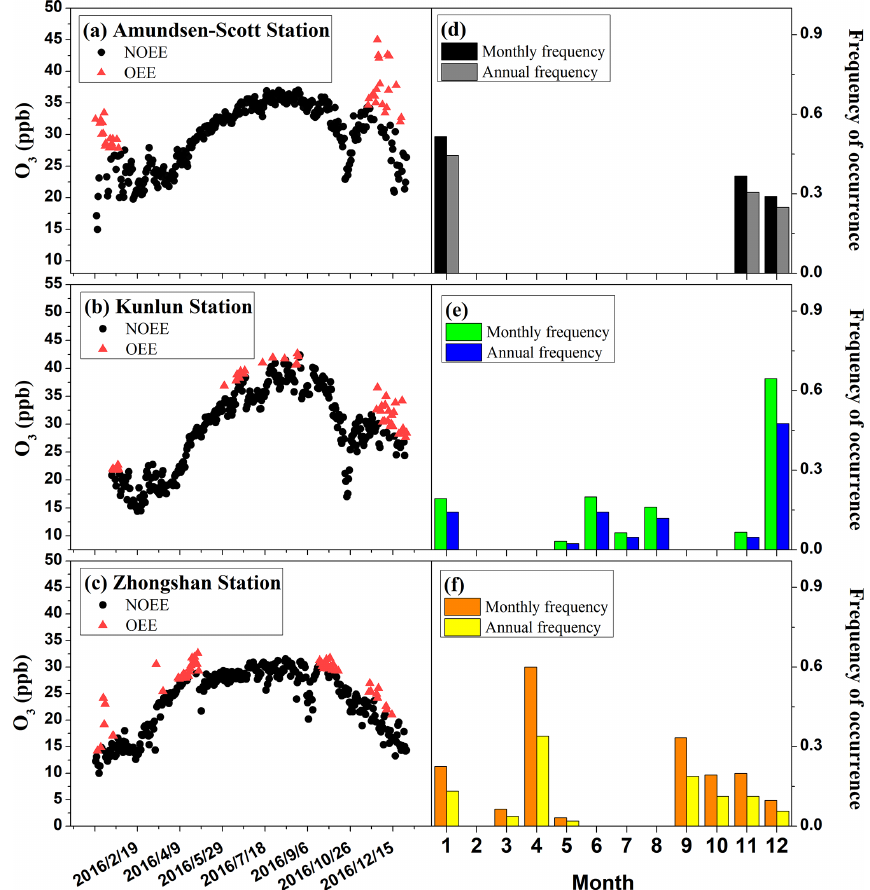
Figure 6. (a–c) The OEEs and (d–f) averaged distribution of OEE occurrence among the different months of 2016 at the three stations. Monthly frequency = number of OEE days for each month ; annual frequency = number of OEE days for each month . number of days in the month total number of OEE days